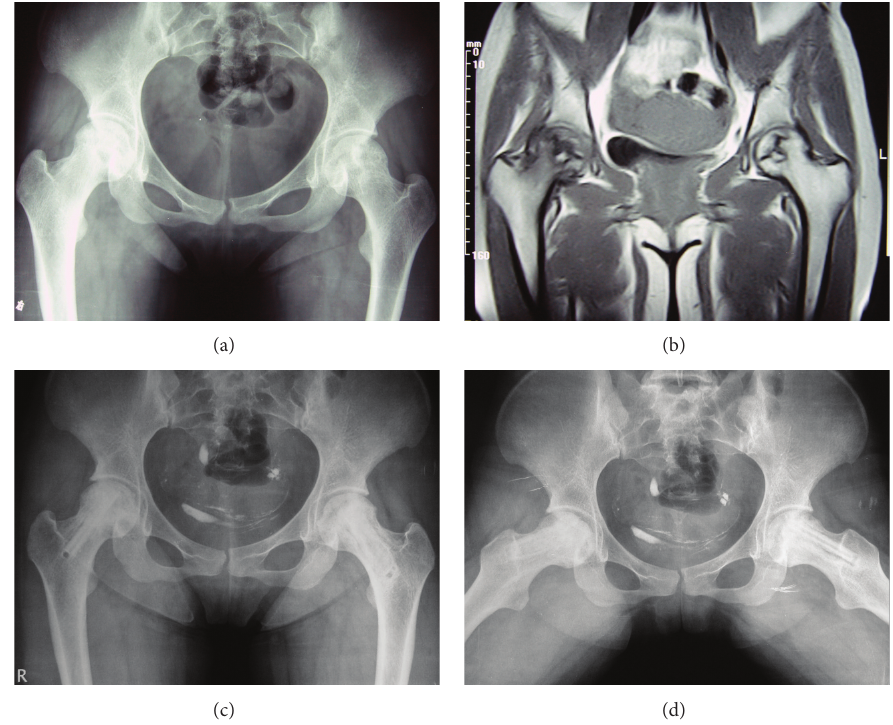
Figure 1: (a) Preoperative radiographs (anteroposterior position of the pelvis) of a 22-year-old woman with Lupus and stage II bilateral hip osteonecrosis. The preoperative Harris hip scores were 74 (right) and 85 (left). The patient received corticosteroid treatment at maintenance doses until the latest follow-up. (b) Preoperative MRI of this patient. (c) and (d) Postoperative radiographs (anteroposterior position and frog-leg position) taken three years after FVFG showed stability of the articular cartilage and femoral head. The postoperative Harris hip scores at the latest follow-up were 90 (right) and 96